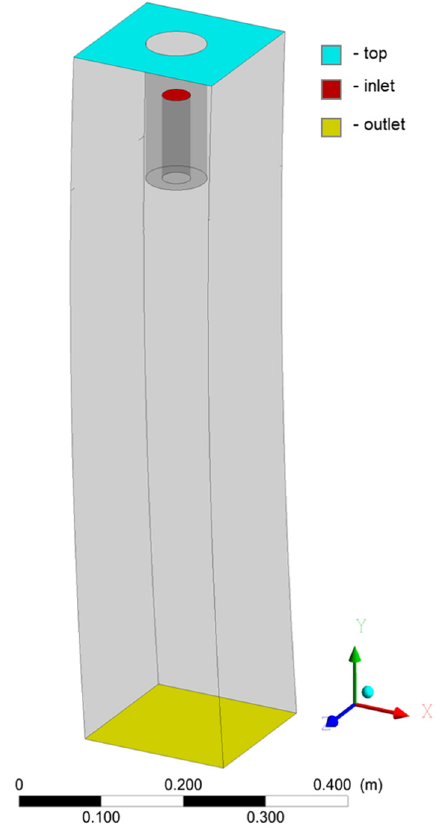
Figure 1. The geometry of the computational model.